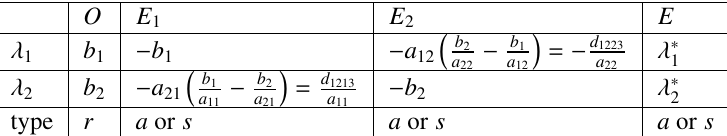
Table 1: The eigenvalues and types of the equilibrium points of the system (7); the abbrevia- tions a, r and s stand for attractor, repeller and saddle,